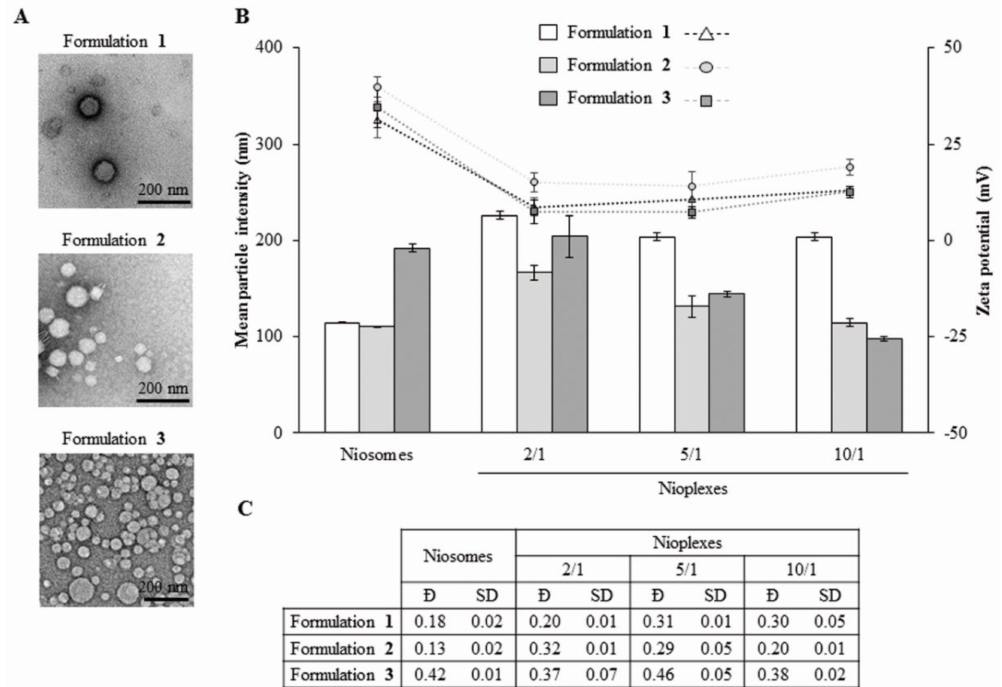
Figure 4. Characterization of niosomes based on formulations 1 , 2 and 3 and their corresponding nioplexes vectoring EGFP plasmid (pEGFP) at cationic lipid/DNA mass ratios 2/1, 5/1 and 10/1. ( A ) Transmission electron microscopy (TEM) images. Scale bar: 200 nm. ( B ) Mean particle intensity (bars) and zeta potential (symbols) values of niosomes and their corresponding nioplexes represented by the mean ± SD of three measurements. ( C ) Dispersity (Ð) values of niosomes and their corresponding nioplexes. Each value represents the mean ± standard deviation (SD) of three